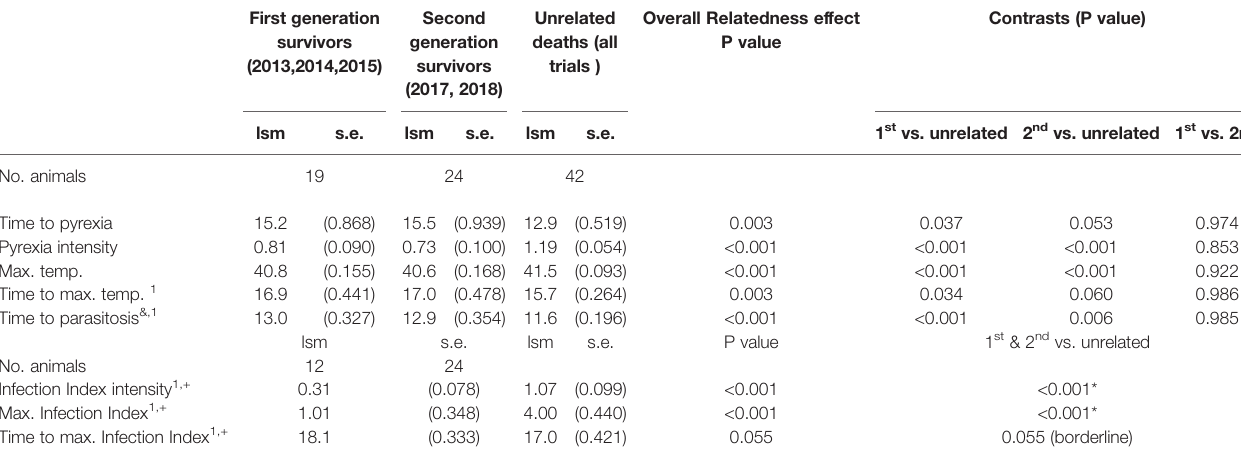
TABLE 3 | Parasitosis and pyrexia data from the surviving offspring and the susceptible unrelated